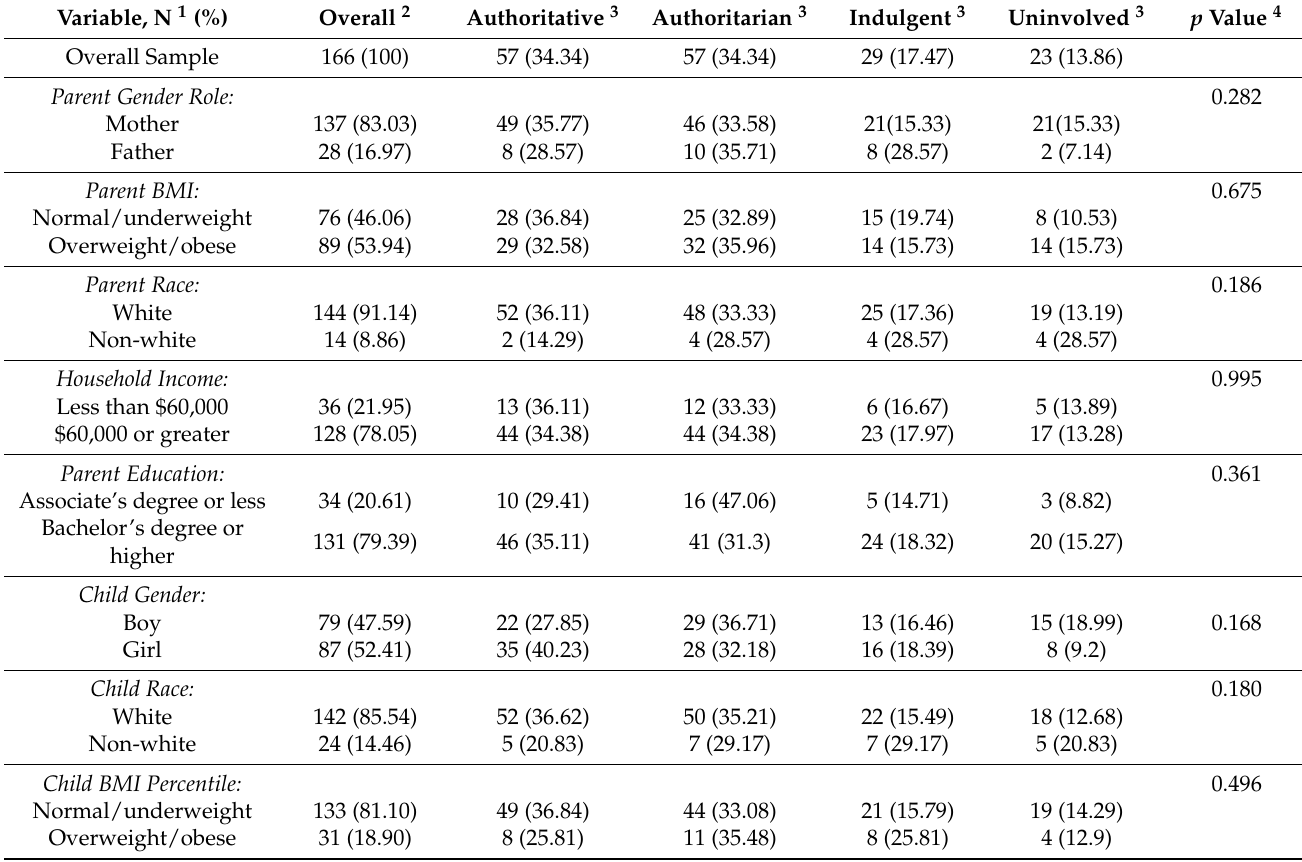
Table 1. Frequency of parents and children demographic information according to parenting